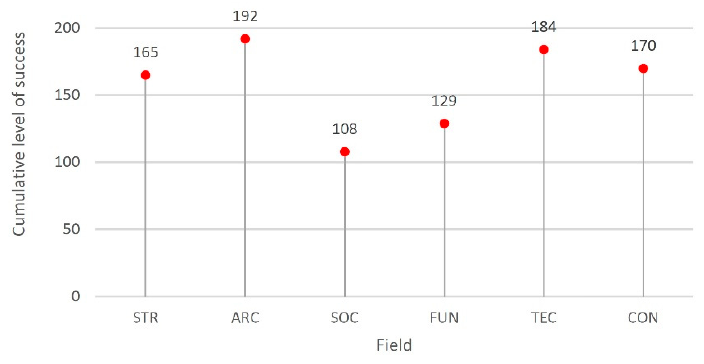
Figure 6. Cumulative level of success for the different fields of action.